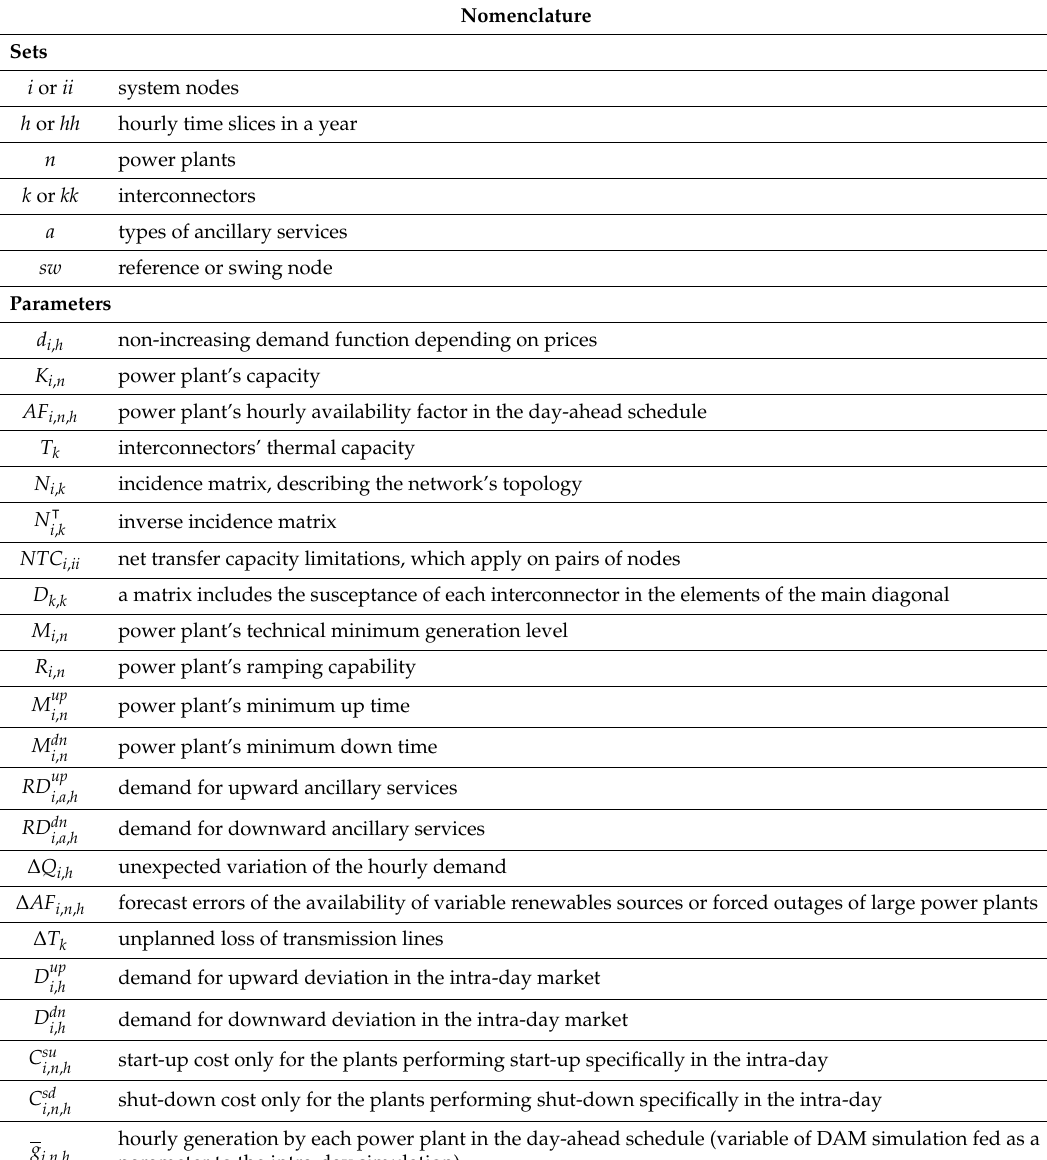
Table 2. Nomenclature of the PRIMES-IEM modelling